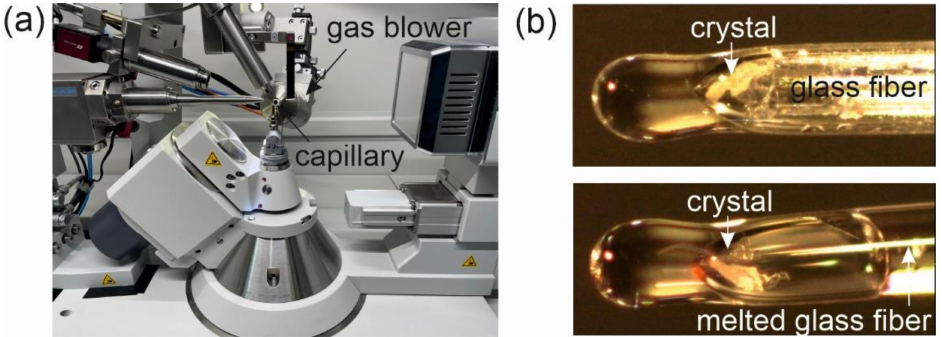
Figure 1. Equipment used for the in situ high-temperature single-crystal study: ( a ) the gas blower (FMB Oxford) inside the XtaLAB Synergy-S diffractometer (Rigaku Oxford Diffraction); ( b ) slawsonite crystal in the quartz capillary at 27 ( above ) and 1000 ◦ C ( below